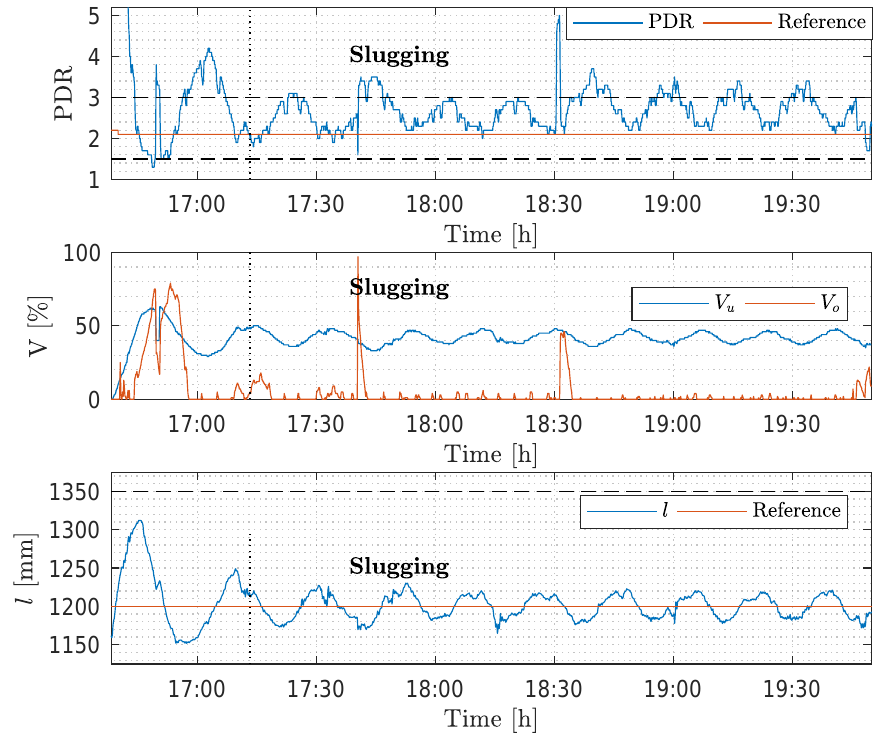
Figure 2. Data collected from an offshore produced water treatment facility in the Danish sector of the North Sea; the set-points are ( l = 1200 mm & PDR =